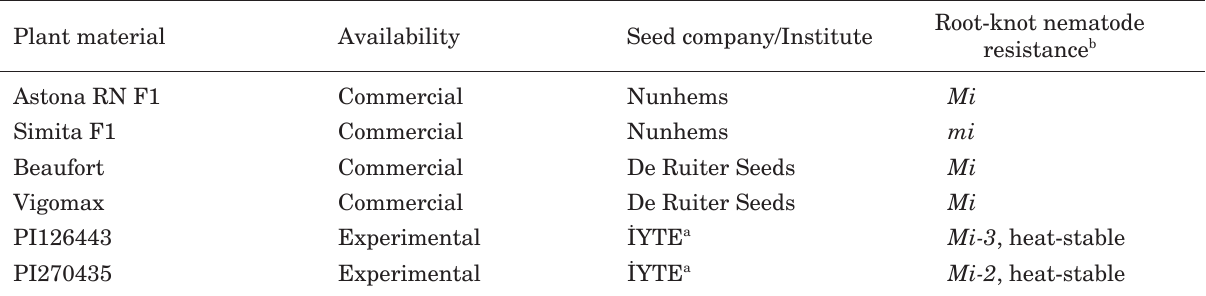
Table 1. Tomato plants, origin and resistance